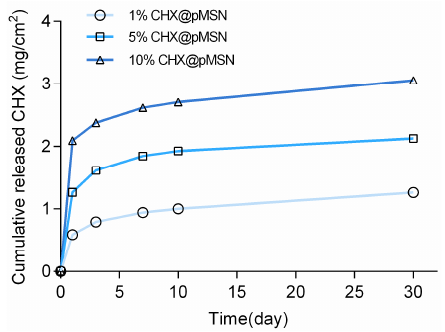
Figure 8. Release profile of cumulative CHX of 1%, 5%, and 10% CHX@pMSN groups at time points